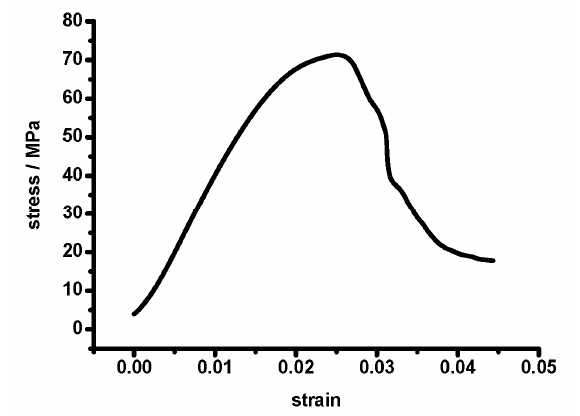
Figure 2. Static compression stress-strain curve of PBX simulation material.